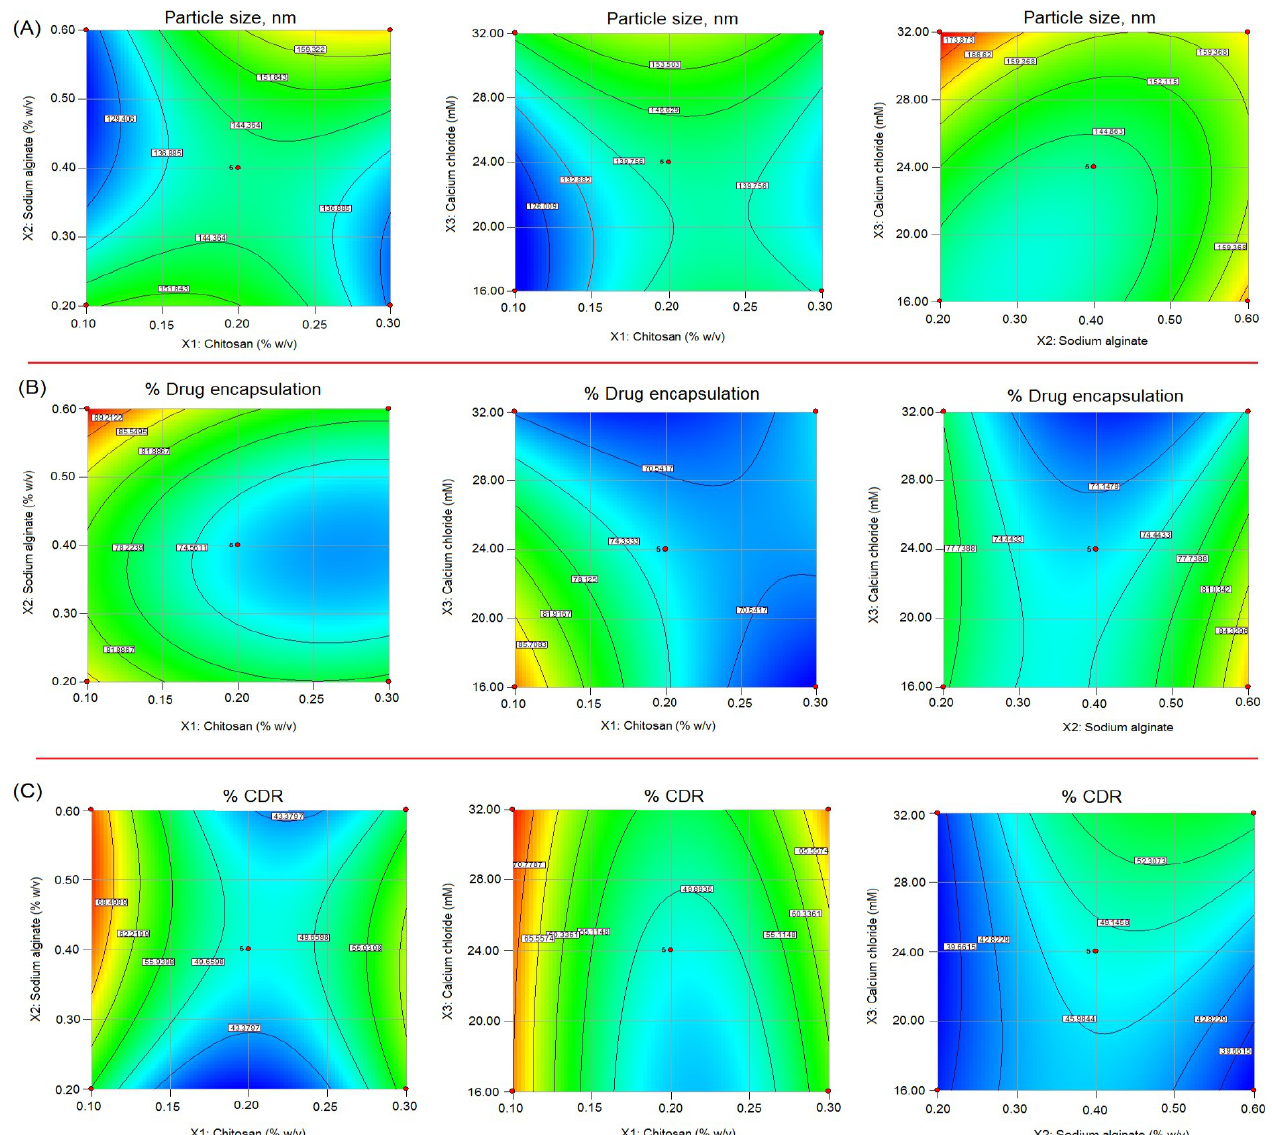
Figure 1. 2D contour response-surface plots showing the influence of chitosan (X1), sodium algi- nate (X2), and calcium chloride (X3) on response parameters: ( A ) particle size (nm); ( B ) %drug en- capsulation and; ( C ) %cumulative drug release (%CDR) of β -SIT-Alg/Ch-NPs-FA.